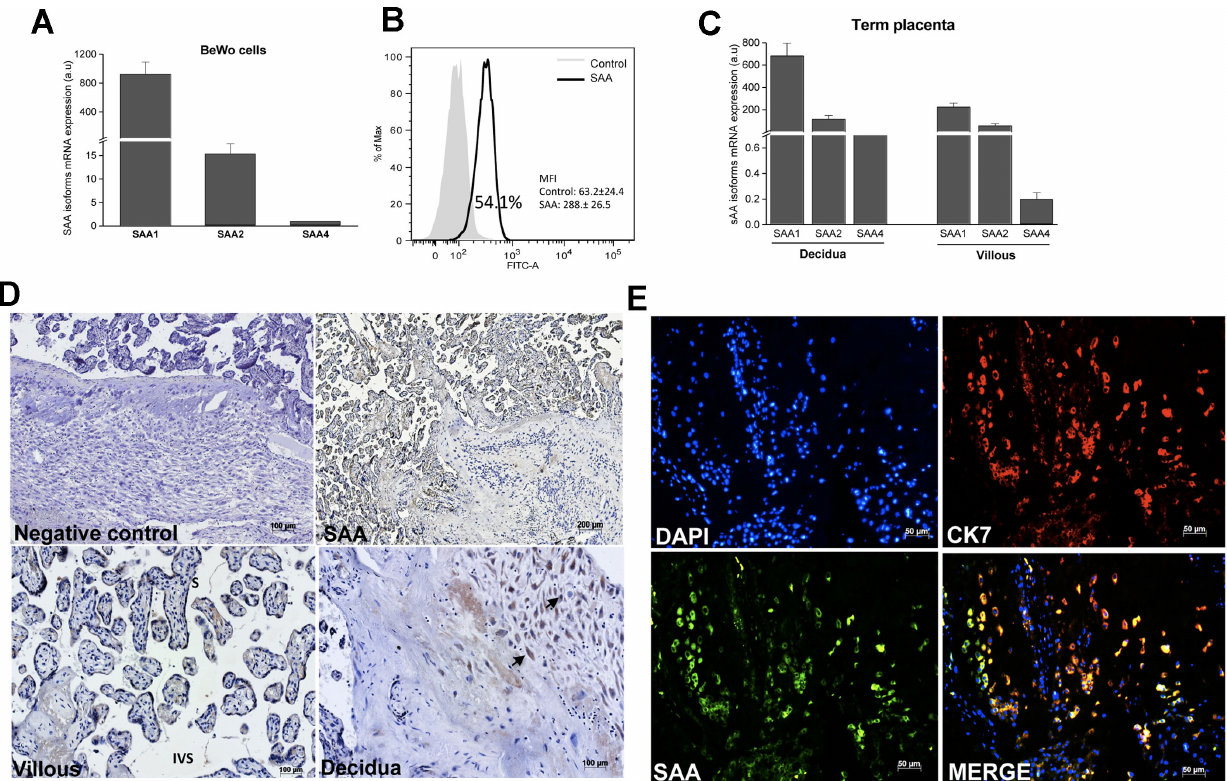
Figure 4. Expression of SAA. (A, C) mRNA expression of SAA isoforms in BeWo cells and term placenta, respectively. The data represent the median 6 SE of four independent experiments. (B) SAA-positive BeWo cells. (D) The photomicrographs show the immunolocalization of SAA in the term placenta. Negative control (upper left); SAA staining (upper right); SAA was detected in syncytiotrophoblast (S) at villous side (lower left); and in decidual cells and trophoblasts at decidua side (arrowhead, lower right); IVS – intervillous space; (E) Immunofluorescence for SAA and CK7 at decidual side of term placenta. The data are representative of three independent experiments.